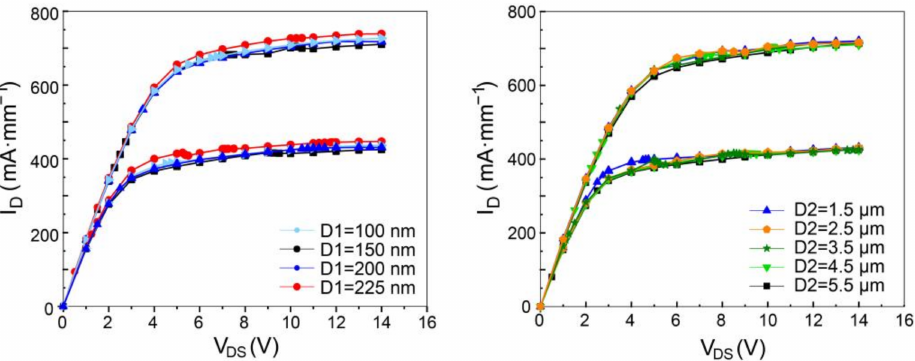
Figure 7. The effect of ( a ) D1 and ( b ) D3 on I D at V gate = 0 V and − 1 V when doping concentration is 7 × 10 16 cm − 3 .